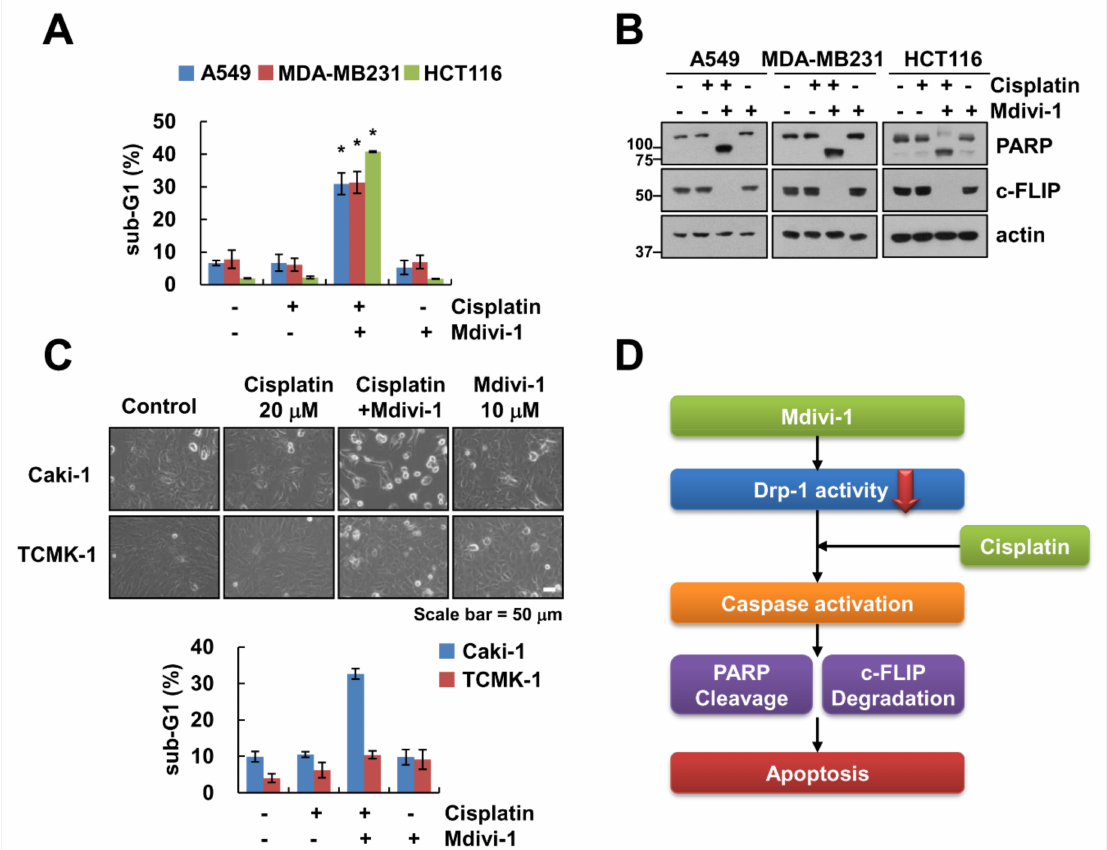
Figure 5. E ff ect of combined treatment of mdivi-1 and cisplatin on apoptosis in other cancer and normal cells. ( A – C ) Indicated cancer cells ( A , B ) or normal renal TCMK-1 cells ( C ) were treated with 10 µ M mdivi-1 alone, 20 µ M cisplatin alone, or mdivi-1 plus cisplatin for 24 h. ( D ) The scheme